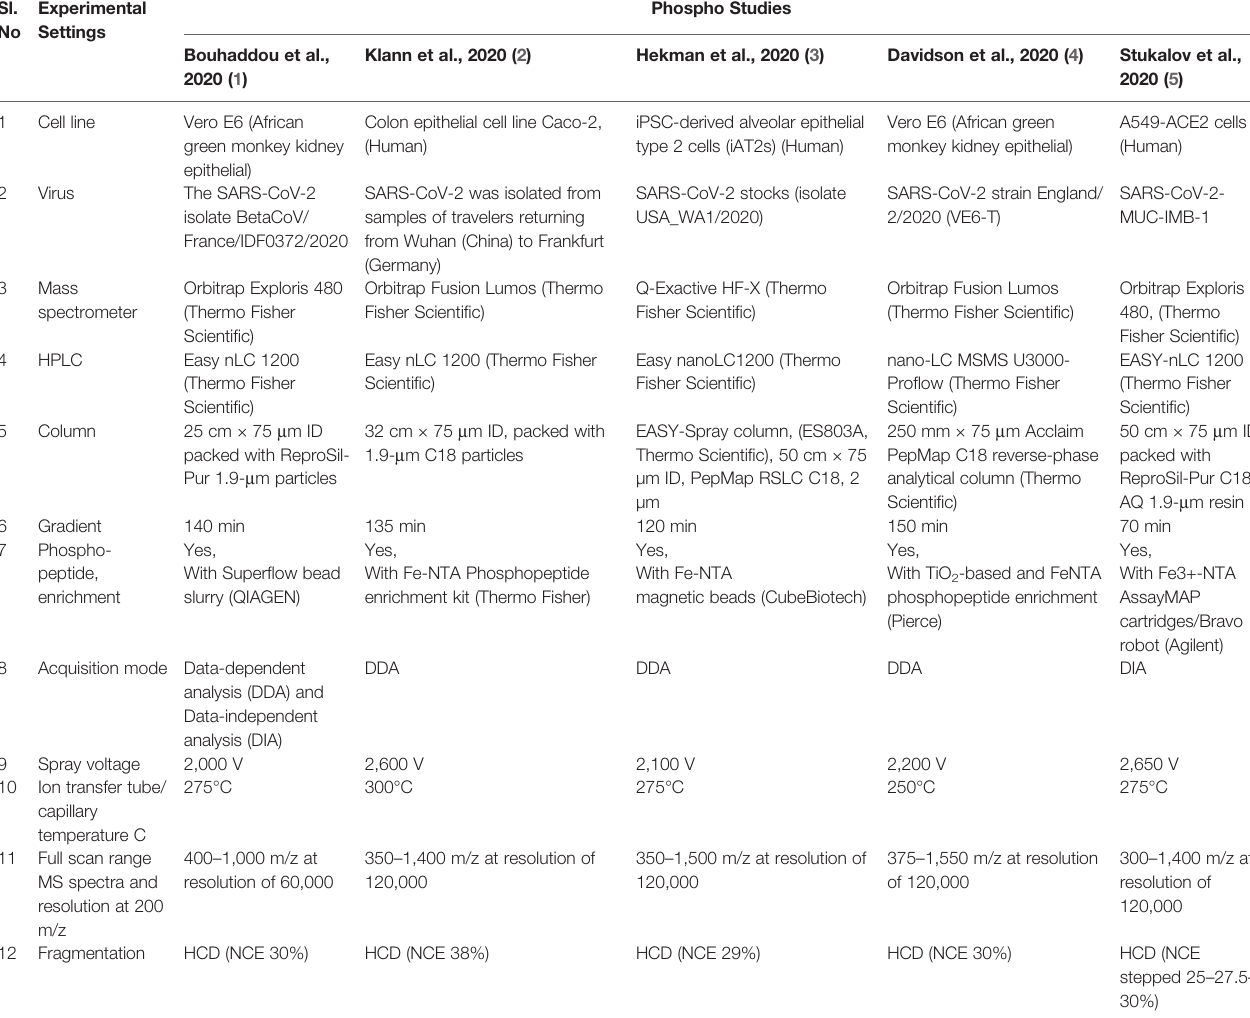
TABLE 2 | Detail of experimental settings of phosphorylation